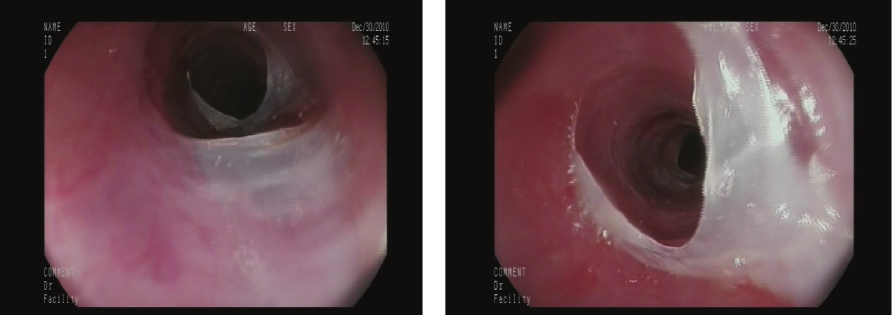
Figure 2: Esophageal webs in mid- and proximal esophagus.